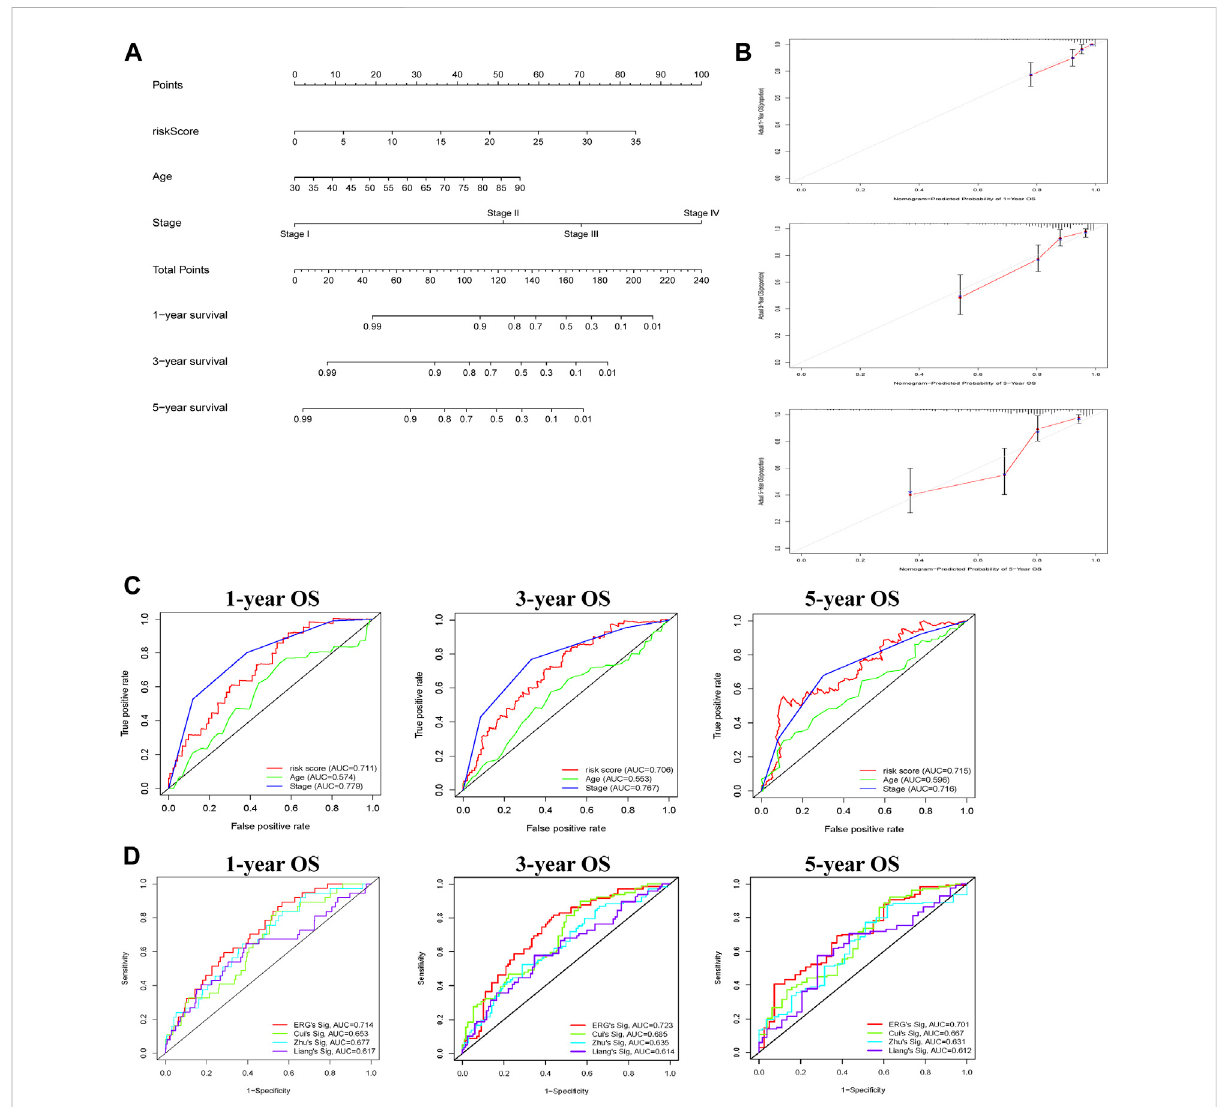
FIGURE 4 ConstructionofnomogramforpredictingOSofpatientswithCOAD. (A) Thenomogram combiningsignaturewithclinicopathologicalfeatures (risk score, age, stage) predicts probability of 1-, 3-, and 5-years OS. (B) The calibration plots reveal nomogram-predicted survival probabilities corresponded closely to the actually observed percentages. (C) The area under the curve (AUC) value of risk score and clinical factors was determined in 1-, 3- and 5-years OS. (D) The AUC of 3 ERGs-related signature and existing gene-related signature in 1-, 3-, and 5-years